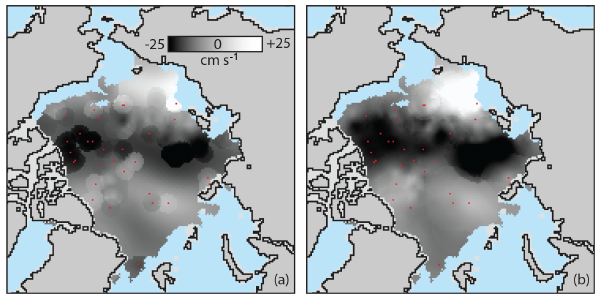
Figure 4. Version 3 (a) and Version 4 (b) Antarctic SSM/I vectors (red) and resulting interpolated vectors (black) for 22 August 2001. Version 3 over-filtered the number of underlying SSM/I vectors, of- ten resulting in an ice field constructed from very sparse underlying data. Version 4 corrected this and includes more SSM/I vectors. Ev- ery fourth vector is plotted for easier